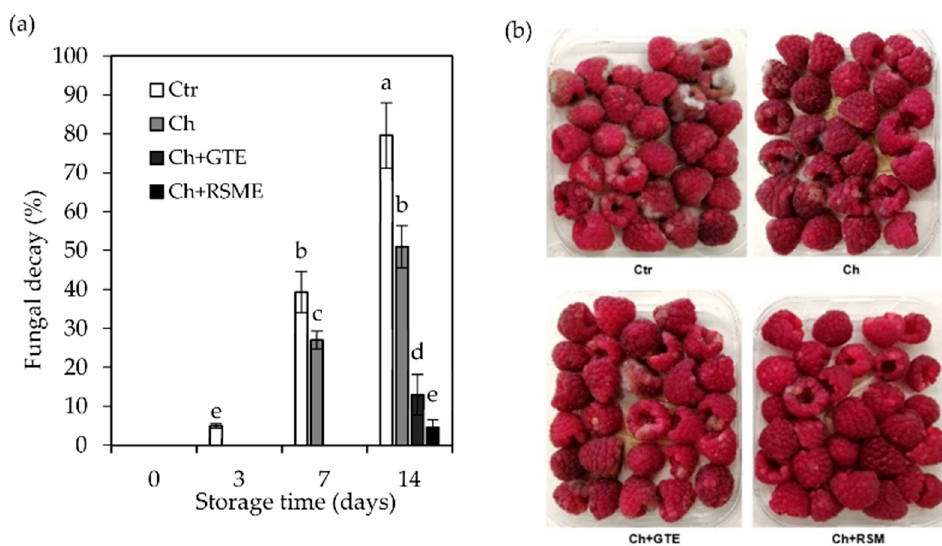
Figure 2. Evolution of fungal decay ( a ) and appearance at 14 days of storage ( b ) of packaged raspberry ( Rubus idaeus L. cv. ‘Kweli’) fruits (no film-pad _Ctr; with film-pad containing green tea extract_Ch + GTE, rosemary extract_Ch + RSME and only chitosan_Ch) stored for 14 days at 4 ◦ C under passive MAP conditions. Means with equal letters are not statistically different by Tukey’s test with 5% significance level.